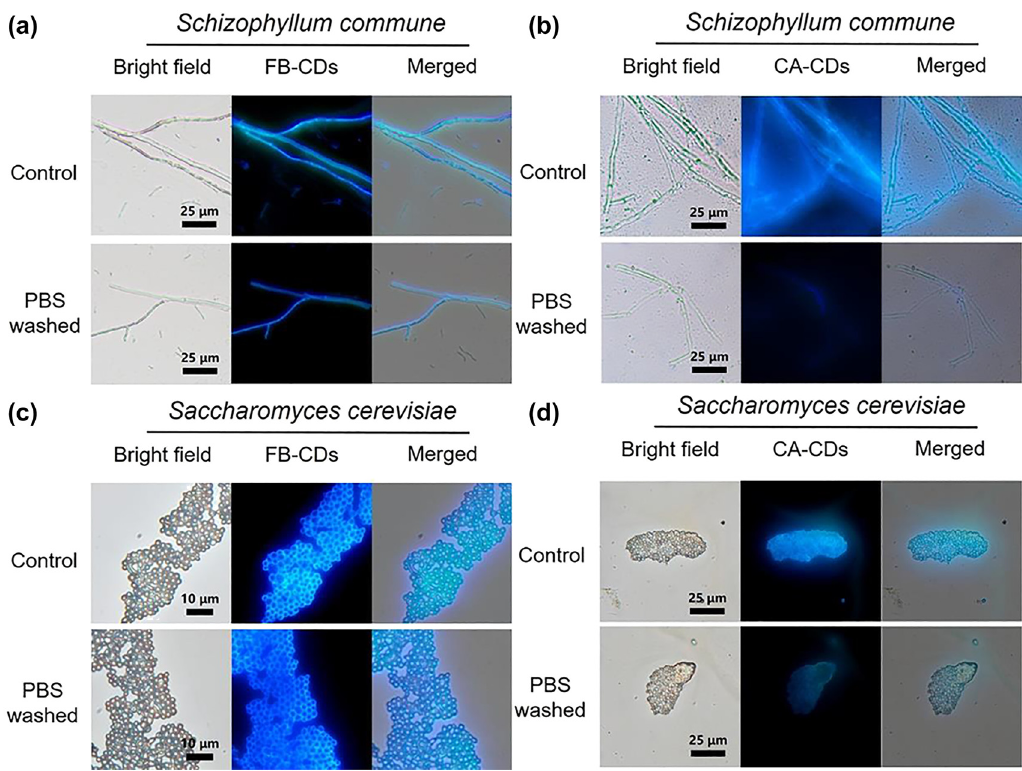
Figure 5: Chitin-targeted fungal fluorescence imaging. FL images of S. commune (a, b) and S. cerevisiae (c, d) using FB-CDs (a, c) and CA-CDs (b, d) as the nanoprobes,